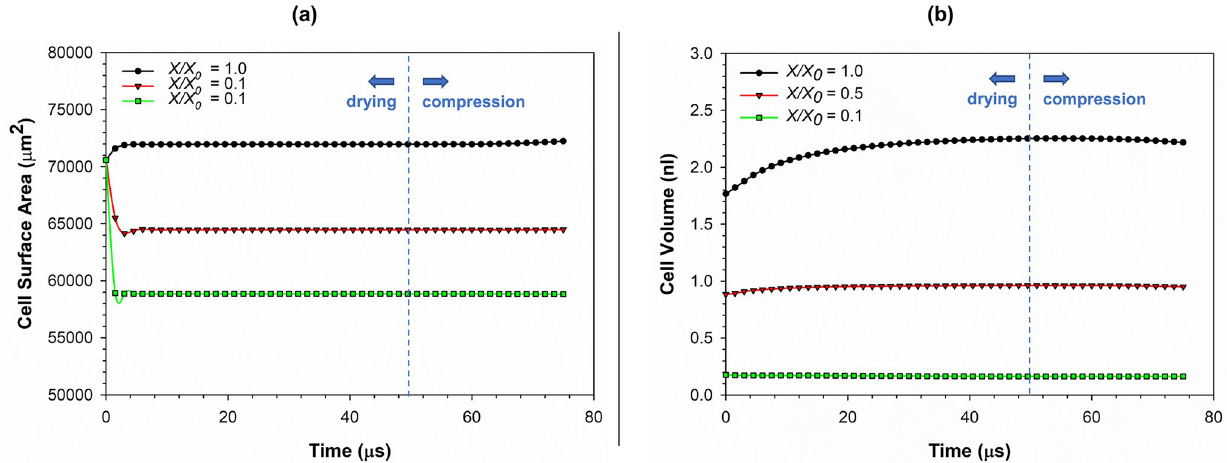
Fig 4. The variation of (a) cell surface area; and (b) cell volume during drying and compression for different dryness levels at a typical turgor pressure of 200 kPa. ( X/X 0 is the normalised moisture